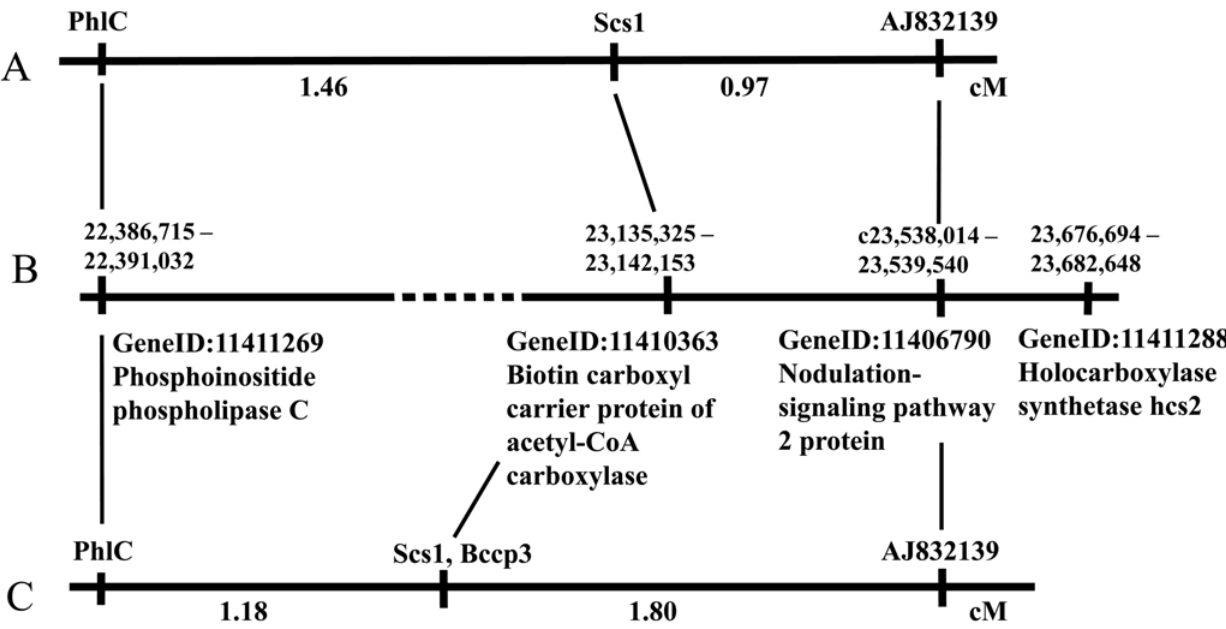
Fig 1. Comparison of the genetic map of pea LGIII and the physical map of M . truncatula chromosome 3 (NC_016409). A. Pea genetic map based on a cross in the background of the VIR320 cytoplasm (Bogdanova et al ., 2012). B. Physical map of M . truncatula . Dashed line stands for a gap of unknown length. C. Pea genetic map based on mapping RIL population in the background of the WL1238